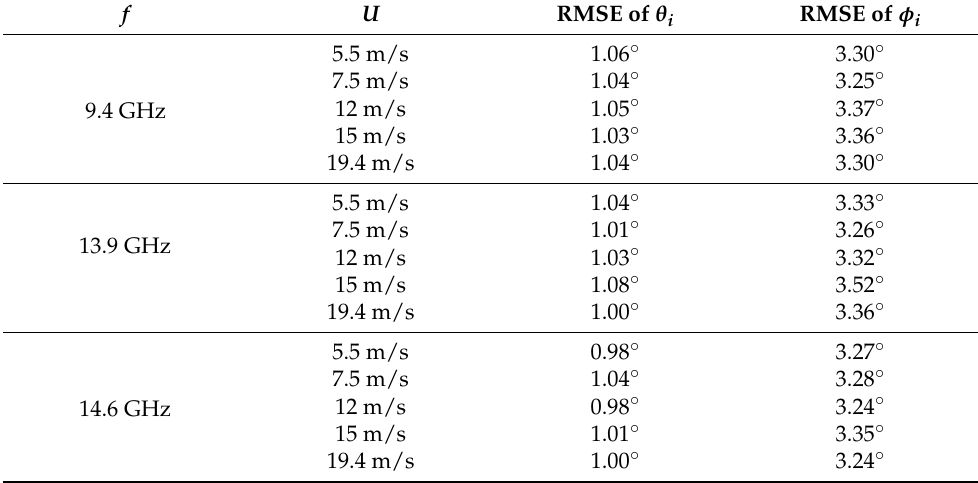
Table 5. Results of 100 realizations of the 9.4 GHz, 13.9 GHz, and 14.6 GHz datasets using the CNN method illustrated in Figure 5. The numbers reported in this table are the average of all